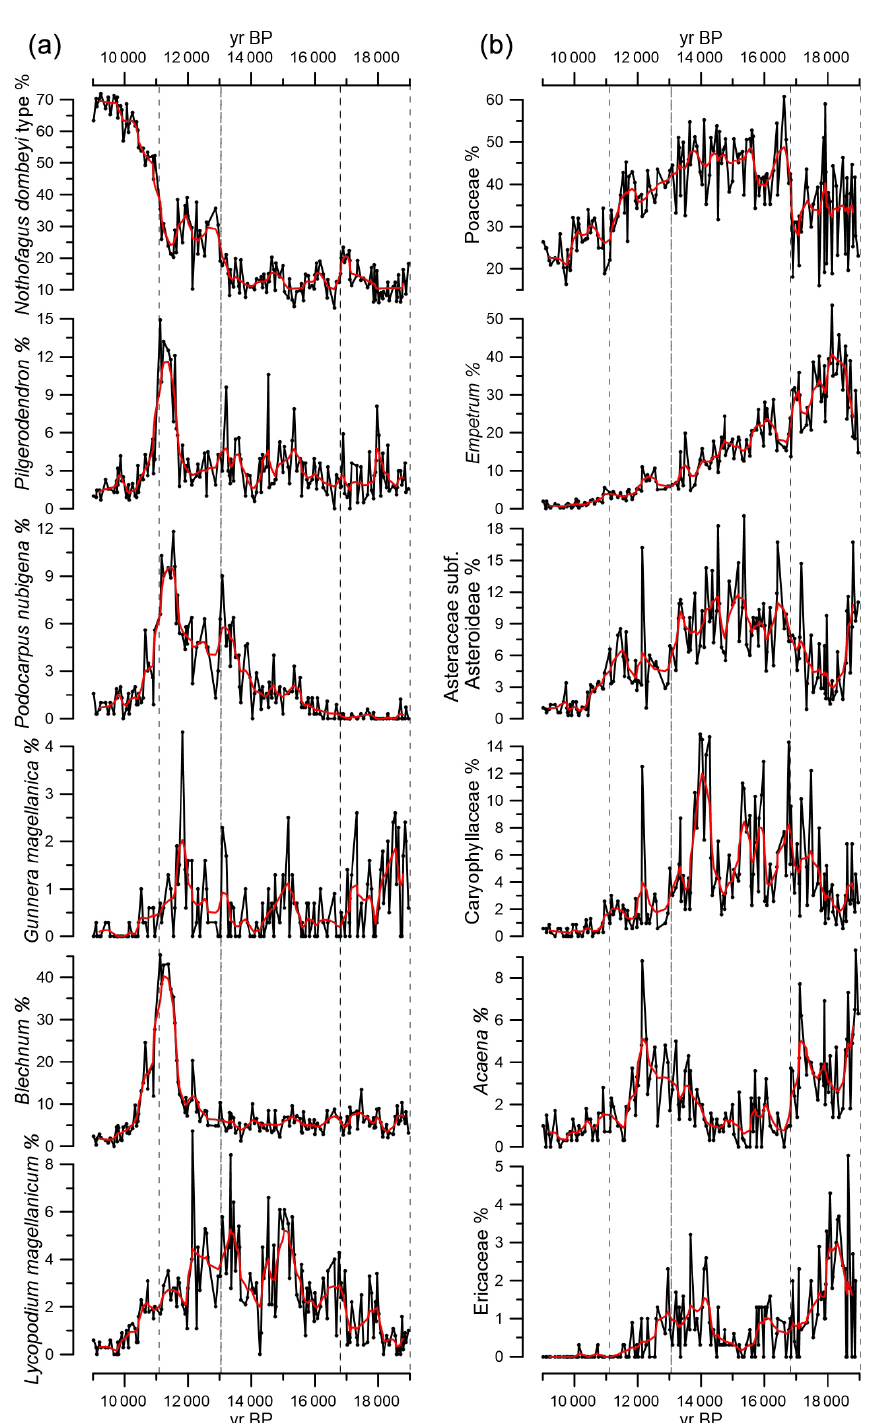
Figure 6. Selected palynomorph abundance of the Lago Edita record shown in the timescale domain. The red lines correspond to weighted running means of seven adjacent samples with a triangular filter. The taxa shown in the left panel are characteristic of humid environments currently found in sectors adjacent to the Pacific coast and/or the Andean tree line in the study area. The taxon Nothofagus dombeyi type, which includes multiple species with contrasting climatic tolerances, is also found in (relatively) humid sectors east of the Andes. The herbs and shrubs shown in the right panel are either cosmopolitan or present in the Patagonian steppe and sectors located at or above the Andean tree line in central-western